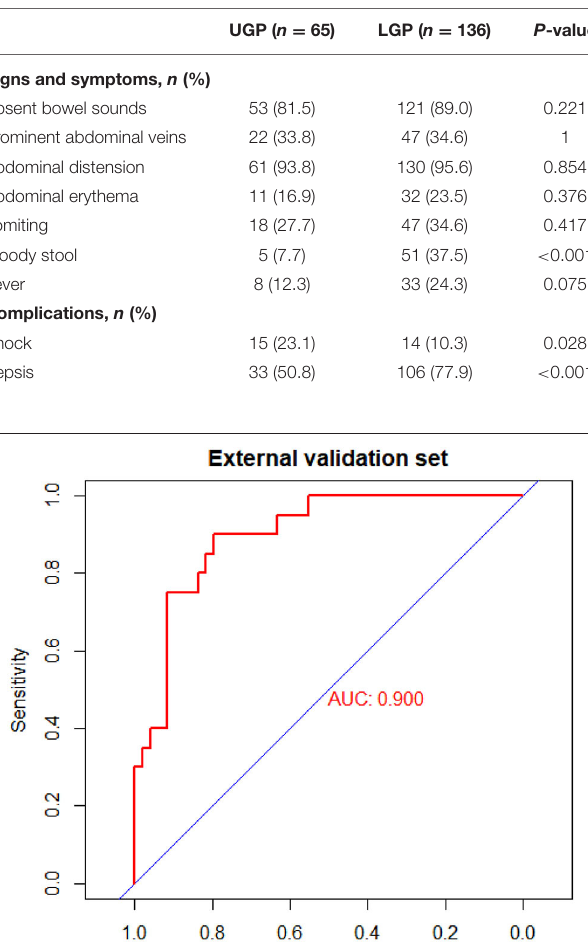
TABLE 3 | Clinical characteristics and complications of patients.